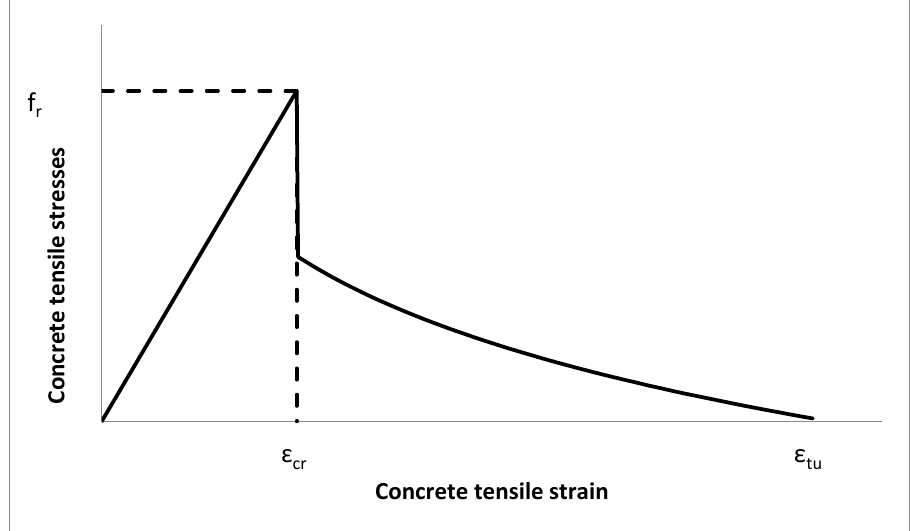
Figure 4. Concrete tensile stress–strain curve.